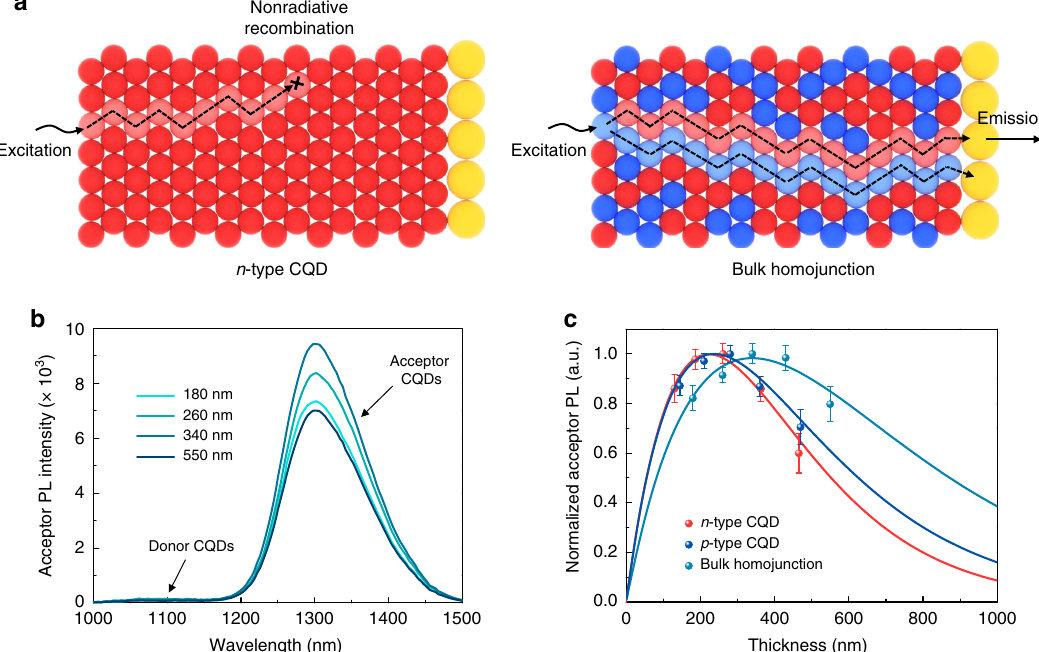
Fig. 3 Carrier diffusion length studies for CQD bulk homojunction fi lms. a The donor layer is illuminated at one end, generating photoexcited carriers that diffuse to the acceptor layer at the other end. The bulk homojunction provides distinct physical paths for each class of charge carrier, enabling ef fi cient carrier transport with minimized nonradiative recombination. b PL intensity with different thicknesses of bulk homojunction (donor) fi lm. c Normalized acceptor PL intensity as a function of donor layer thickness (dot). Fits to data (solid line) indicate the enhancement in the carrier diffusion length (dotted line) in bulk homojunction fi lm compared with n -type and p -type CQD fi lms. The average (symbols) and standard deviation (error bars) are calculated from a sample of three CQD fi lms in each